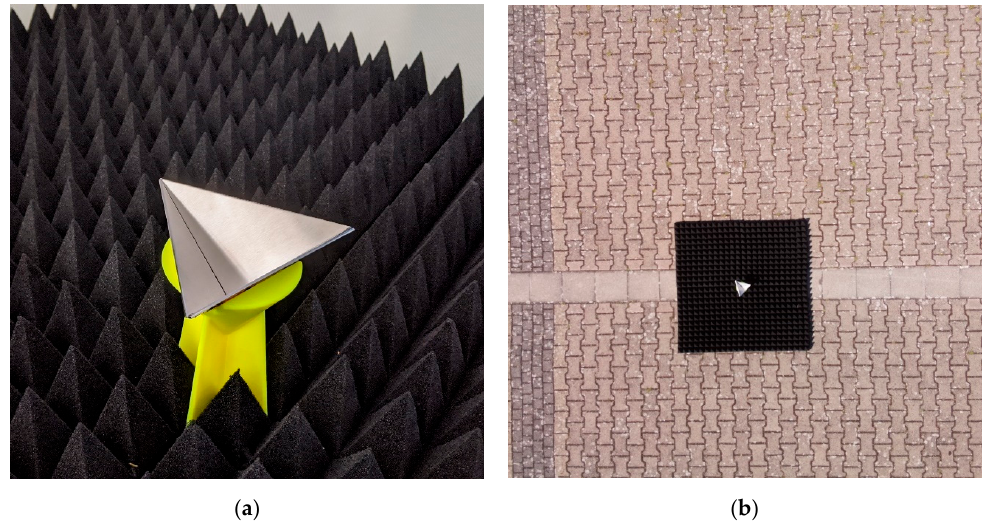
Figure 6. Corner cube reflector with 27.6 m 2 radar cross-section (RCS) in a 3D printed stand. The Figure6. Corner cubereflectorwith 27.6 m 2 radar cross-section (RCS)in a3D printedstand. The reflector reflector is surrounded by absorbing mats in a pyramid style. ( a ) Close-up view from the reflector in issurroundedbyabsorbingmatsinapyramidstyle. ( a )Close-upviewfromthereflectorinthelaboratory. the laboratory. ( b ) View from the UAV down to the reflector while test flight. ( b ) View from the UAV down to the reflector while test